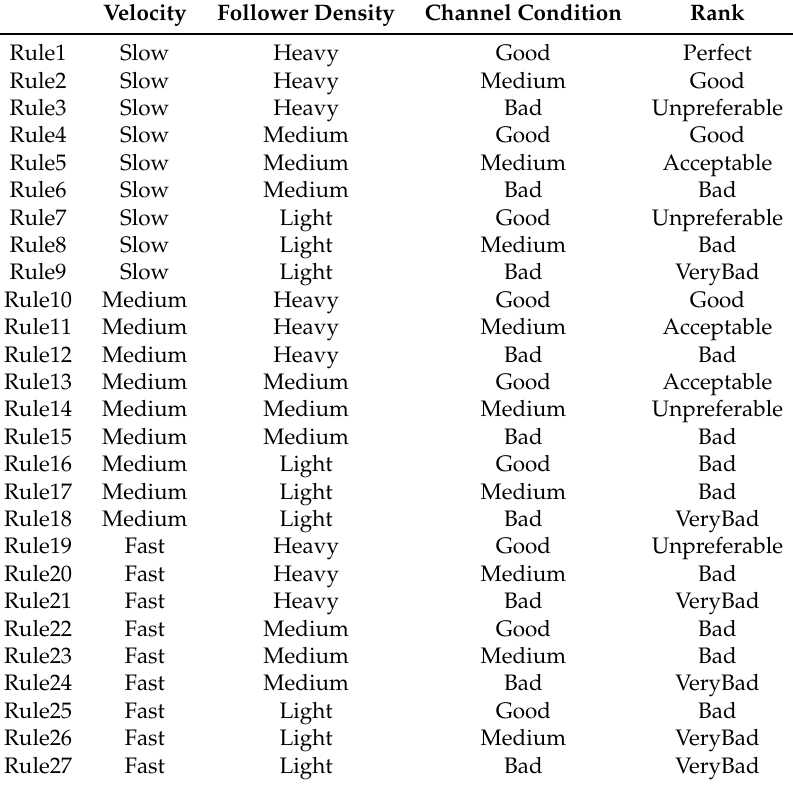
Table 1. Rule Base.